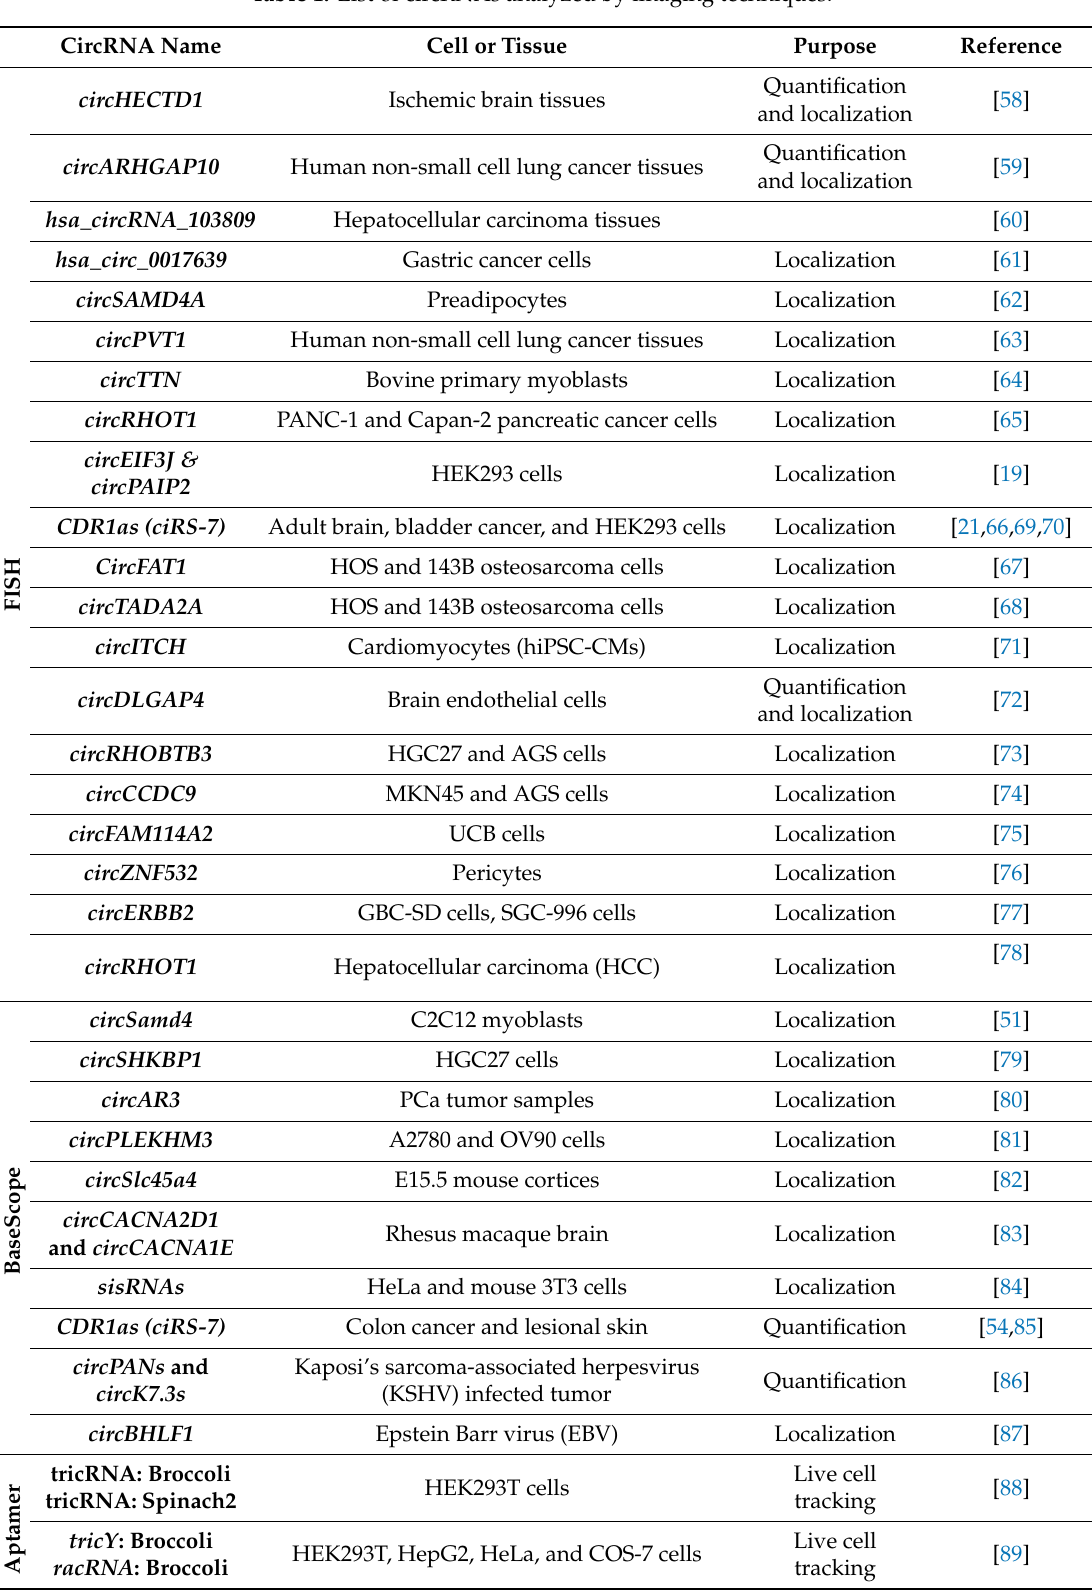
Table 1. List of circRNAs analyzed by imaging